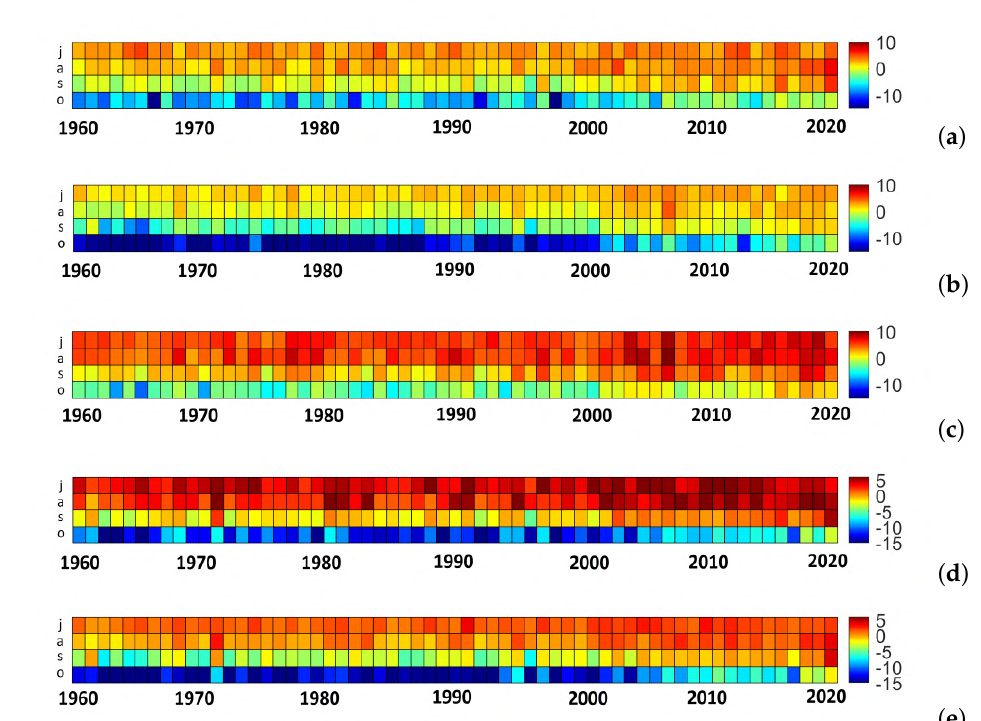
Figure 11. Changes in the mean monthly air temperature (in ◦ C) over the Siberian Arctic seas from July (J) to October (O): ( a )—Kara Sea, ( b )—East Siberian Sea, ( c )—Chukchi Sea; ( d )—Laptev Sea (70–75 ◦ N), ( e )—Laptev Sea (75–80 ◦ N).